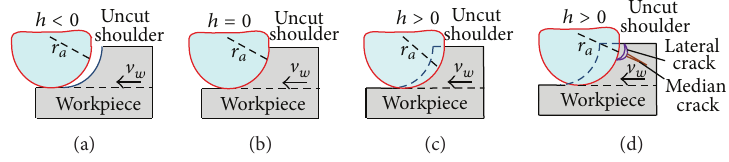
Figure 5: Abrasive cutting process under intermittent machining in UAMEG.